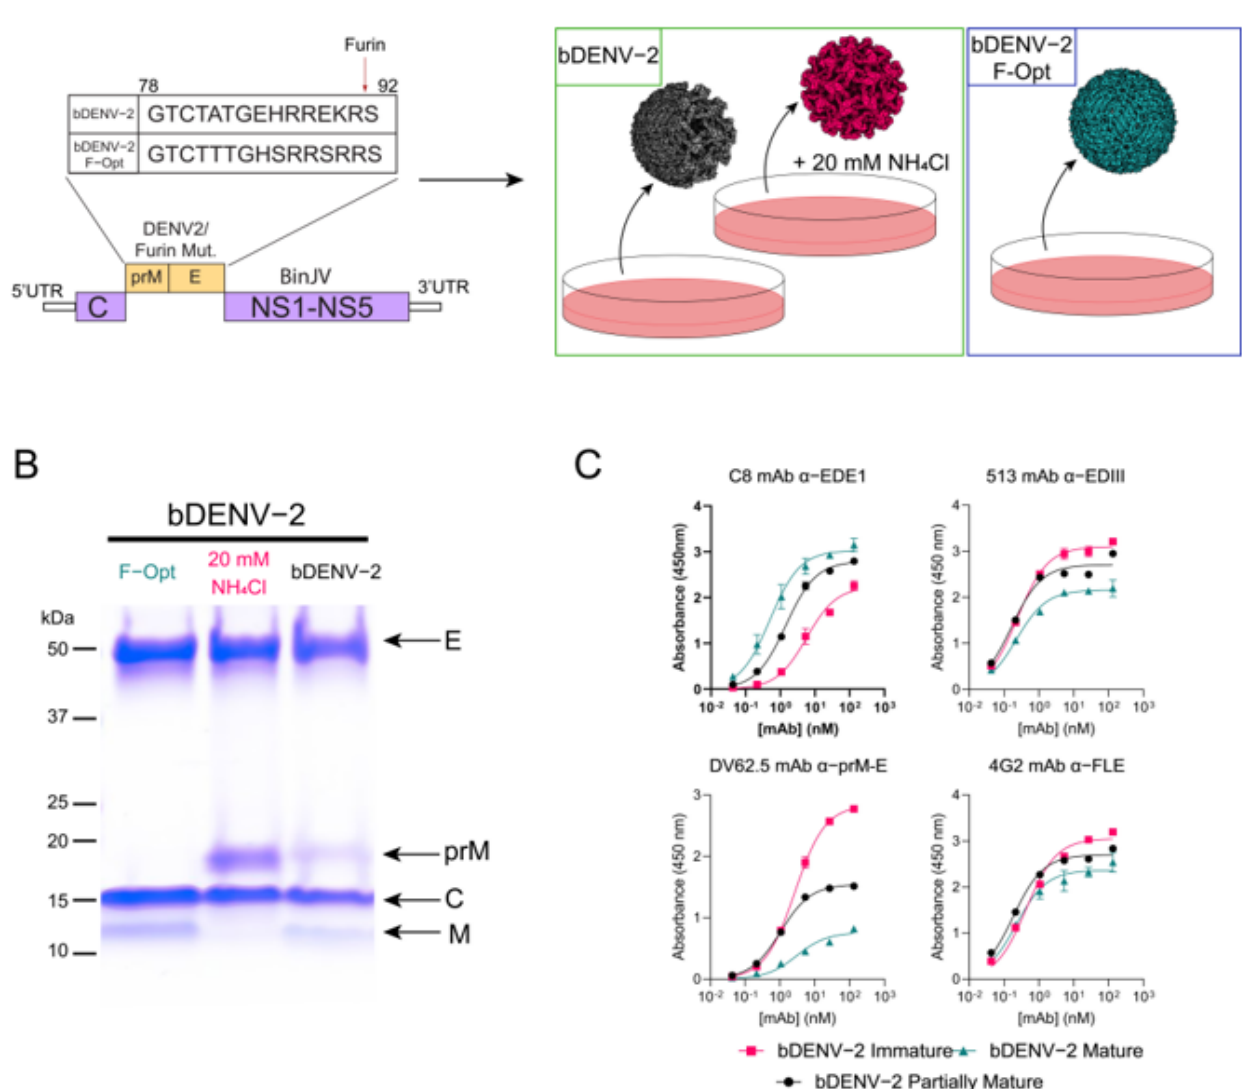
Figure 1. Generation of chimeric bDENV-2 viruses, analysis of purity, and mAb binding kinetics. ( A ) Schematic of chimeric bDENV-2 genome with and without pr-M cleavage site mutations and the generation of viruses of varying maturities in C6/36 cell culture. ( B ) SDS-PAGE analysis of purified virions with molecular weight ladder and structural proteins (envelope (E), pre-membrane (prM), capsid (C), and membrane (M)) indicated. ( C ) ELISA curves of prM/E specific mAbs to mature (teal), immature (pink), and partially mature (black) bDENV-2. Dissociation constants and Bmax were determined using a one-site specific binding model on Graphpad Prism